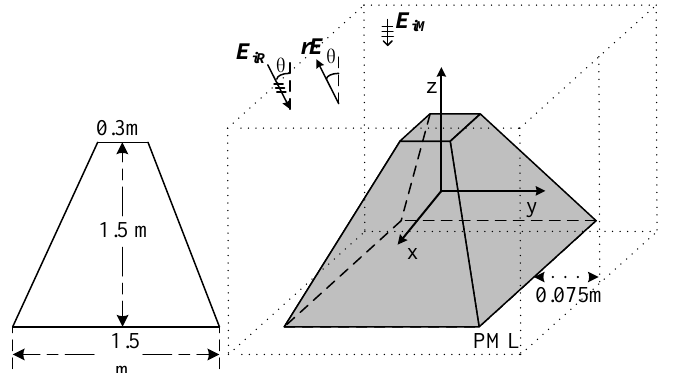
E of the metal cylinder structure. iM